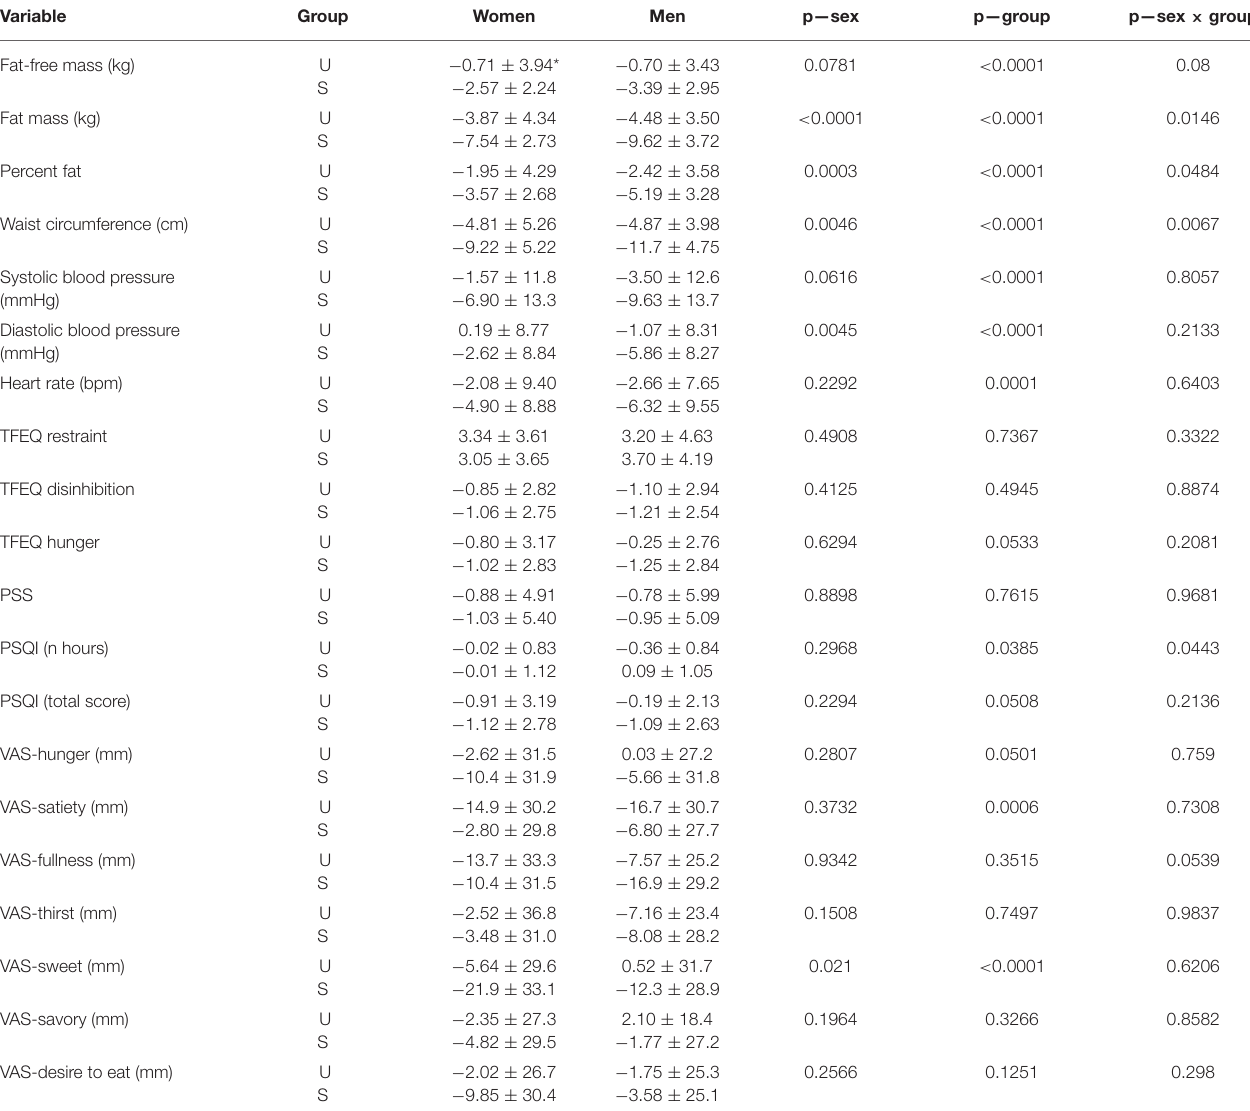
TABLE 4 | Changes induced by the intervention on outcome variables in the two groups of responders to LED. Variable Group Women Men p—sex p—group p—sex ×